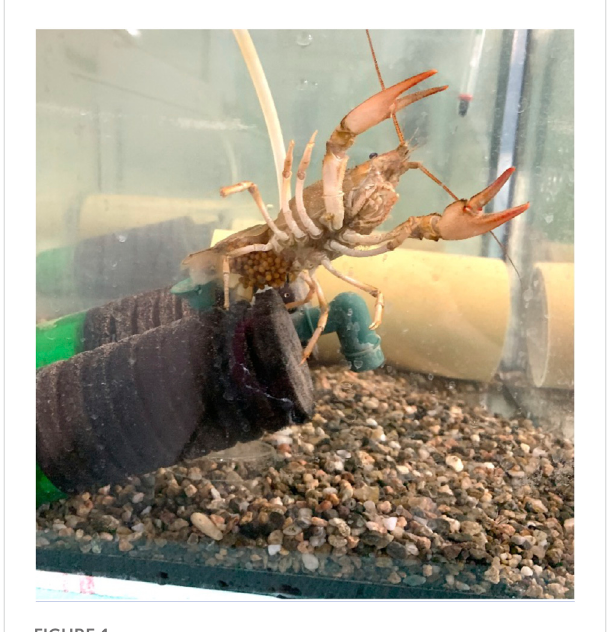
Ovigerous P. leptodactylus cray fi sh collected from the lake Vegoritida and transferred to laboratory